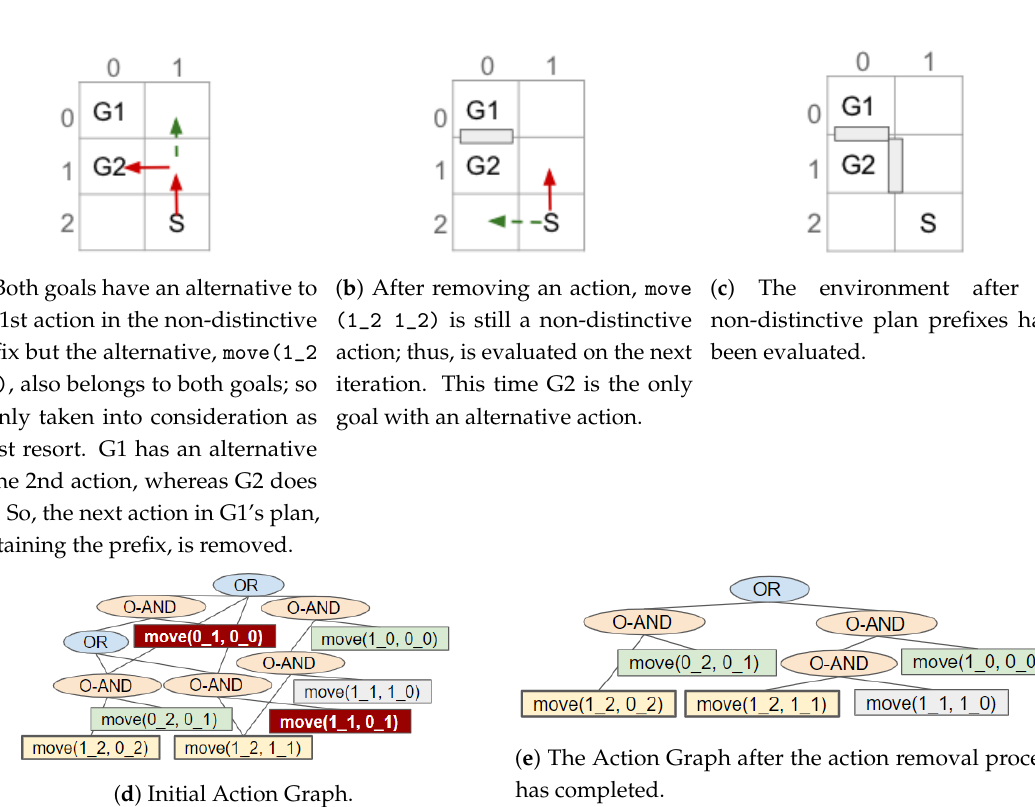
Figure 11. Example GRD problem, in which both goals have an alternative to the plan(s) containing the non-distinctive prefix. In all example environments a longest non-distinctive plan is indicated with red arrows, and the alternative action(s) by a green dashed arrow.